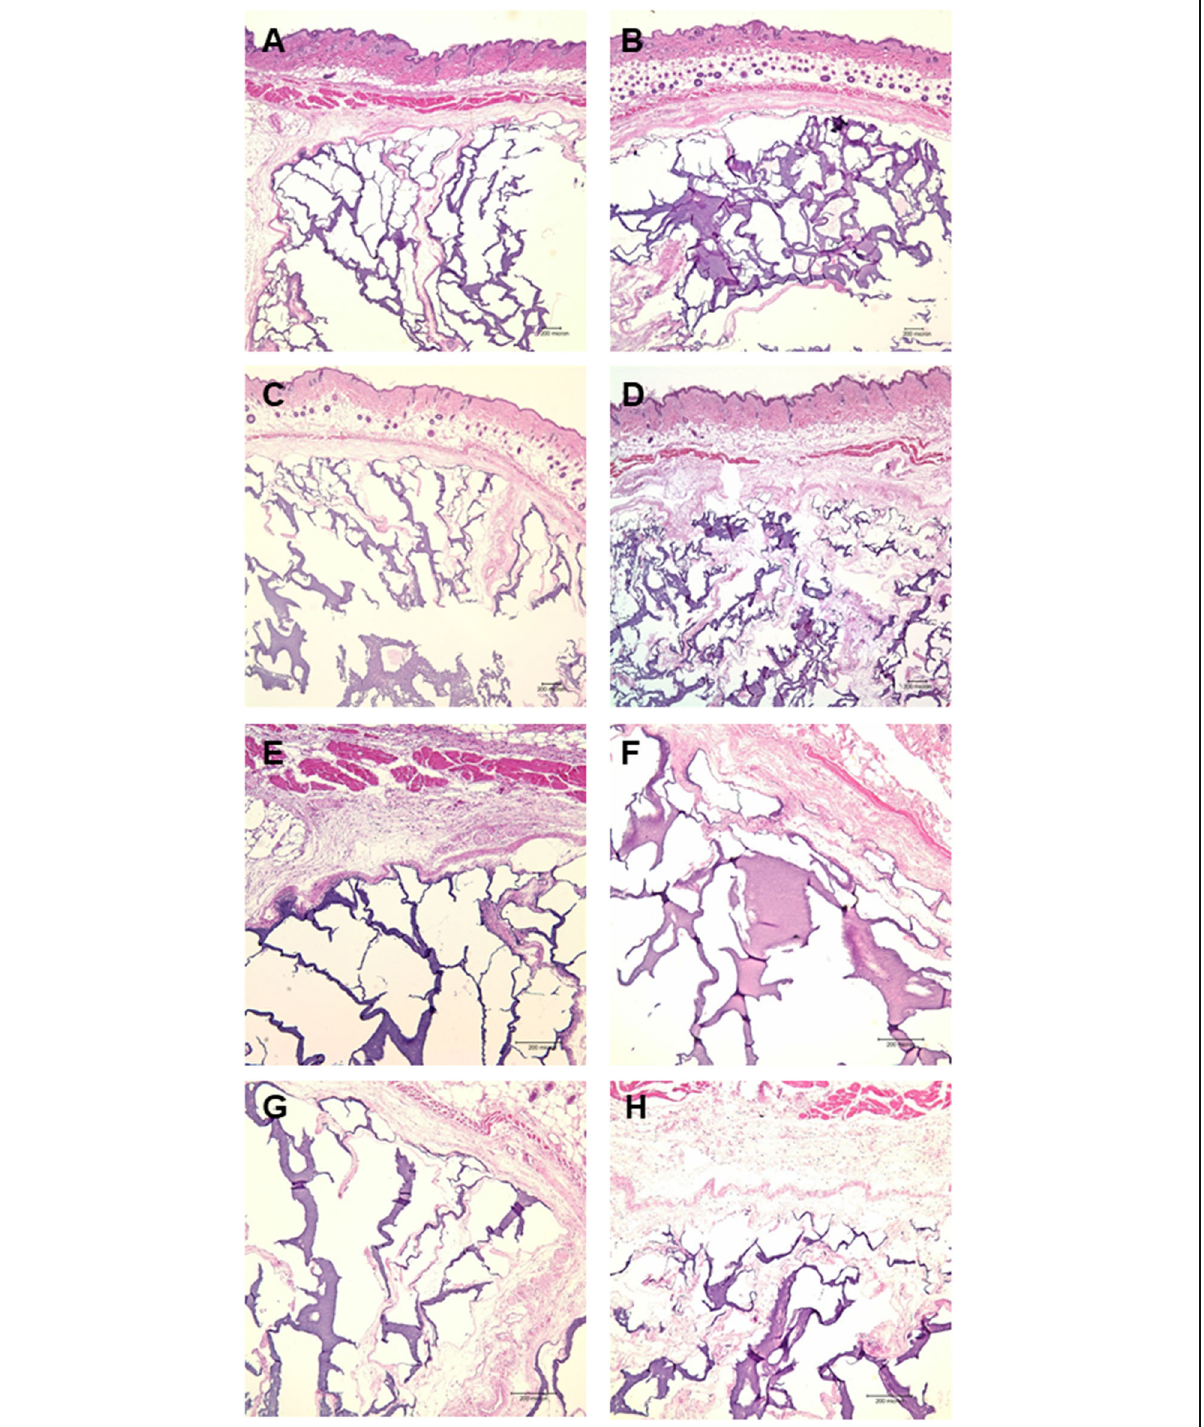
Fig. 2 Microscopic view of the hydrogel groups stained with HE. a , e The hydrogel only group showed the active infiltration of cells and the ingrowth of host tissue into the hydrogel (HE; original magnification, × 40, × 100). b , f Hydrogel combined with bFGF produced more abundant fibrous soft tissue extending from the surrounding tissues into the hydrogel compared to hydrogel alone (HE; original magnification, × 40, × 100). c , g Hydrogel combined with fibroblasts also produced invaginated host tissue and collagen matrices (HE; original magnification, × 40, × 100). d , h Hydrogel mixed with bFGF and fibroblasts induced the most abundant fibrous matrix (HE; original magnification, × 40, ×